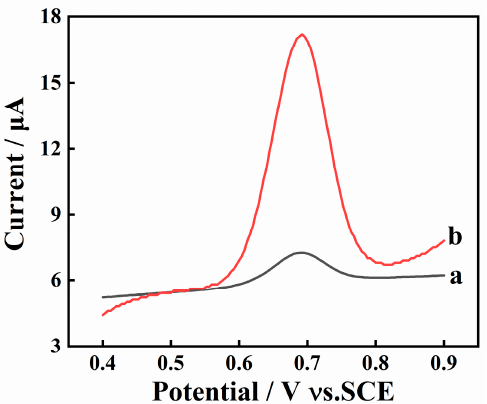
Figure 2. SWV curves of 10 µ M SY in 0.1M PBS (pH 7.0) on bare GCE (a) and AGCE (b); Accumulation potential: 0 mV; Accumulation time: 15 s.